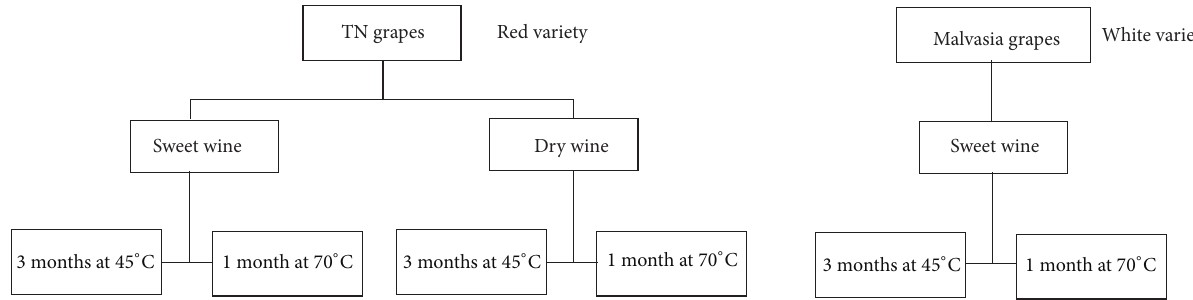
Figure 1: Scheme of the experience carried out: Tinta Negra (TN) dry and sweet wines were industrially elaborated and heated at 45 ∘ C during 3 months. Similarly, a sweet wine was also produced from Malvasia cultivar. For comparison purposes, all wines were baked at overheating conditions (70 ∘ C during 1